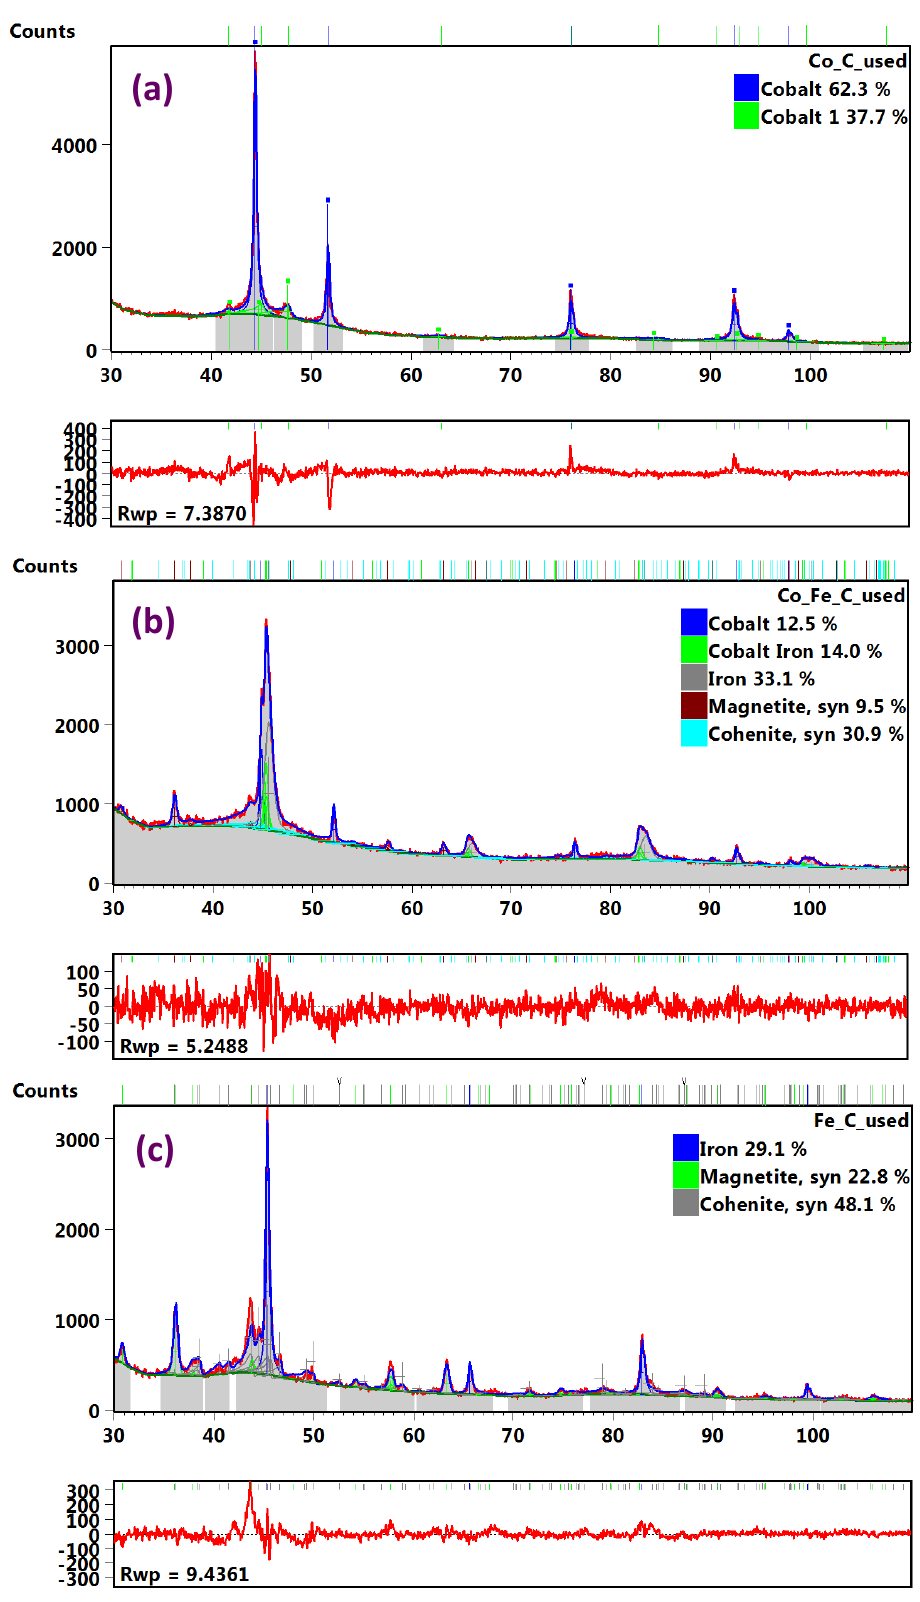
Figure 19. The RQA curve fitting of the used ( a ) Co/C ( b ) Co-Fe/C, and ( c ) Fe/C catalyst samples by XRD analysis.